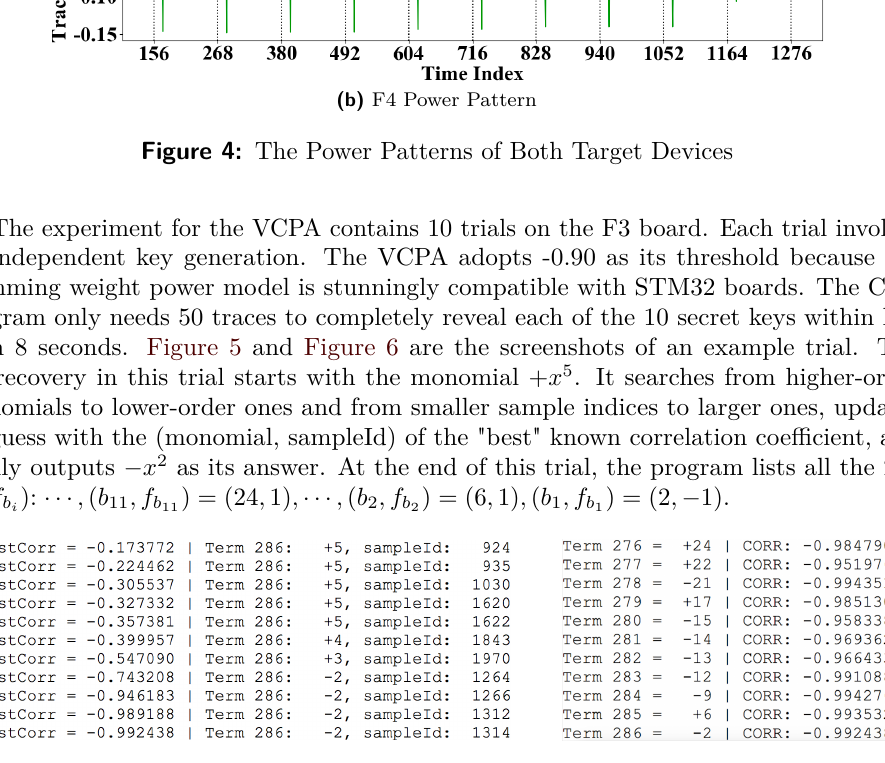
Figure 5: The f b (i.e., Term 286) Recovery Figure 6: The Result of the 1